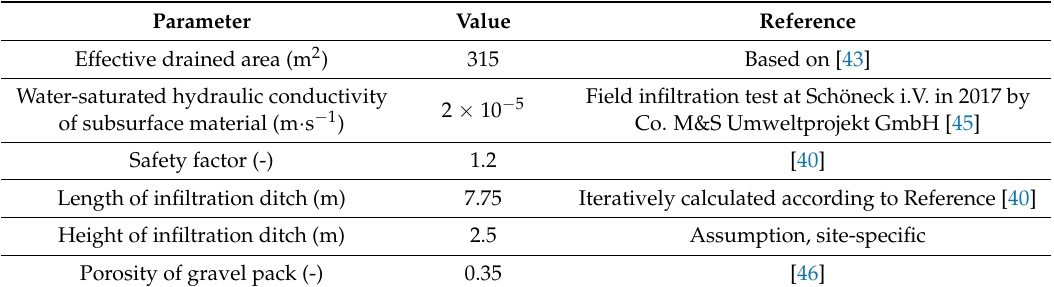
Table 2. Input parameters for precipitation infiltration ditch dimensioning after [40].